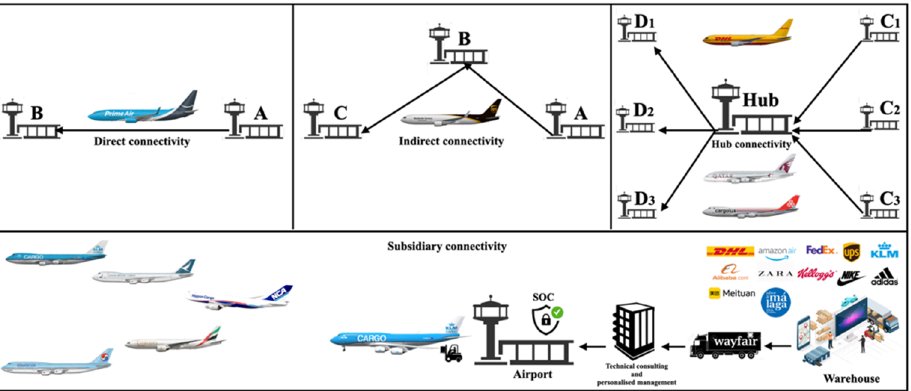
Figure 5. The choice of Cargo airport connectivity category by freight forwarders and online com- panies. Source: Author’s own elaboration. nies. Source: Author’s own